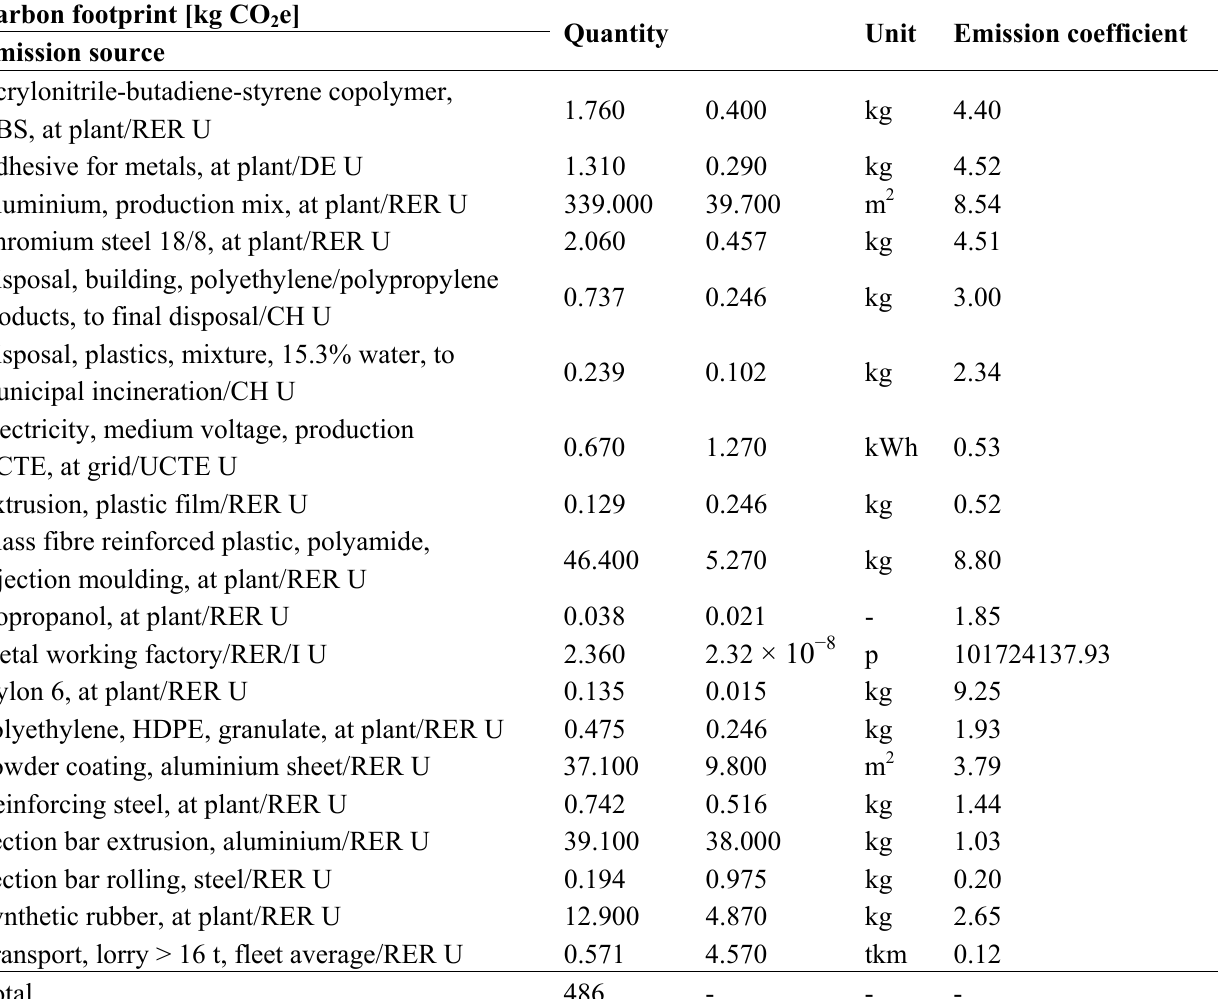
Table 3. Carbon footprint of aluminum window